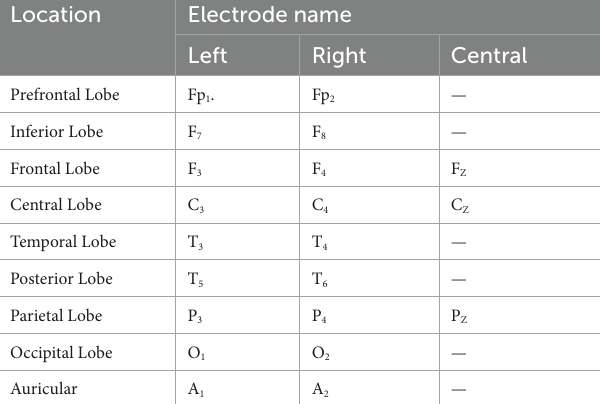
TABLE 1 Electrode position